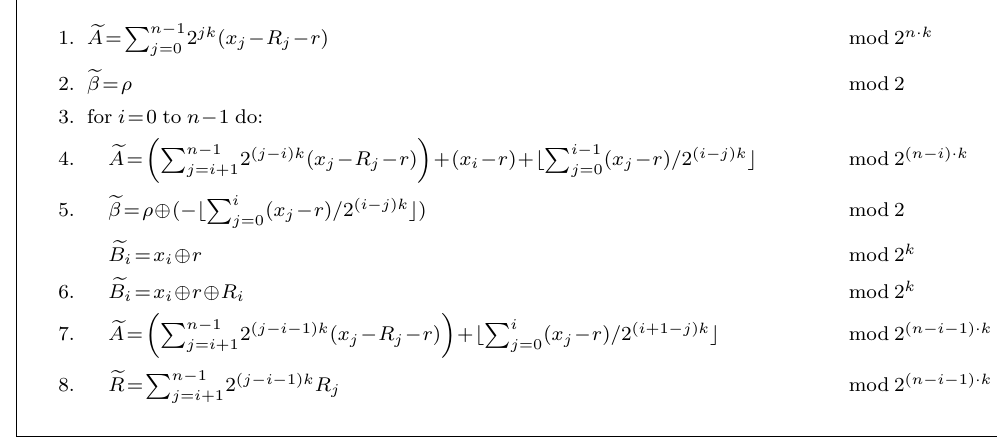
Figure 3: Intermediate values of all variables used in Algorithm